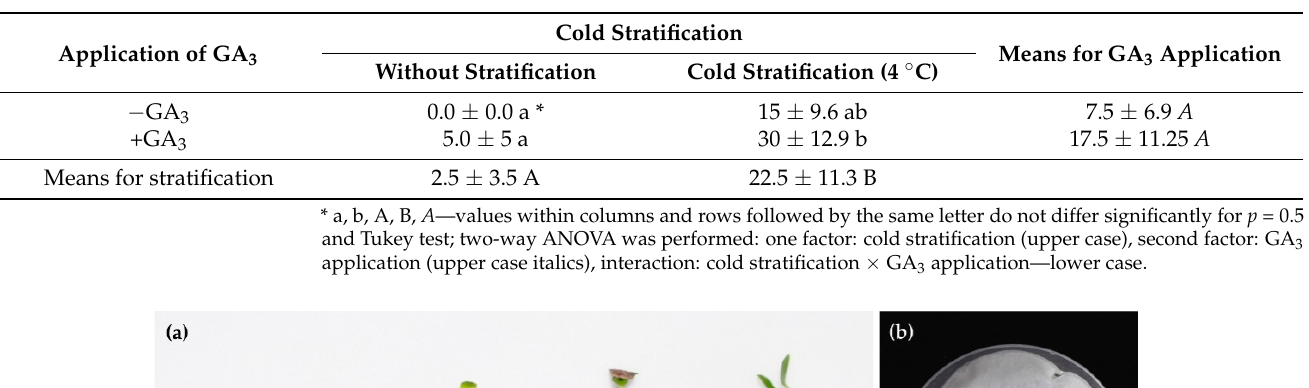
Table 7. The effects of cold stratification and gibberellin application on germination ability of Ranunculus illyricus seeds [% per plate ± SE].